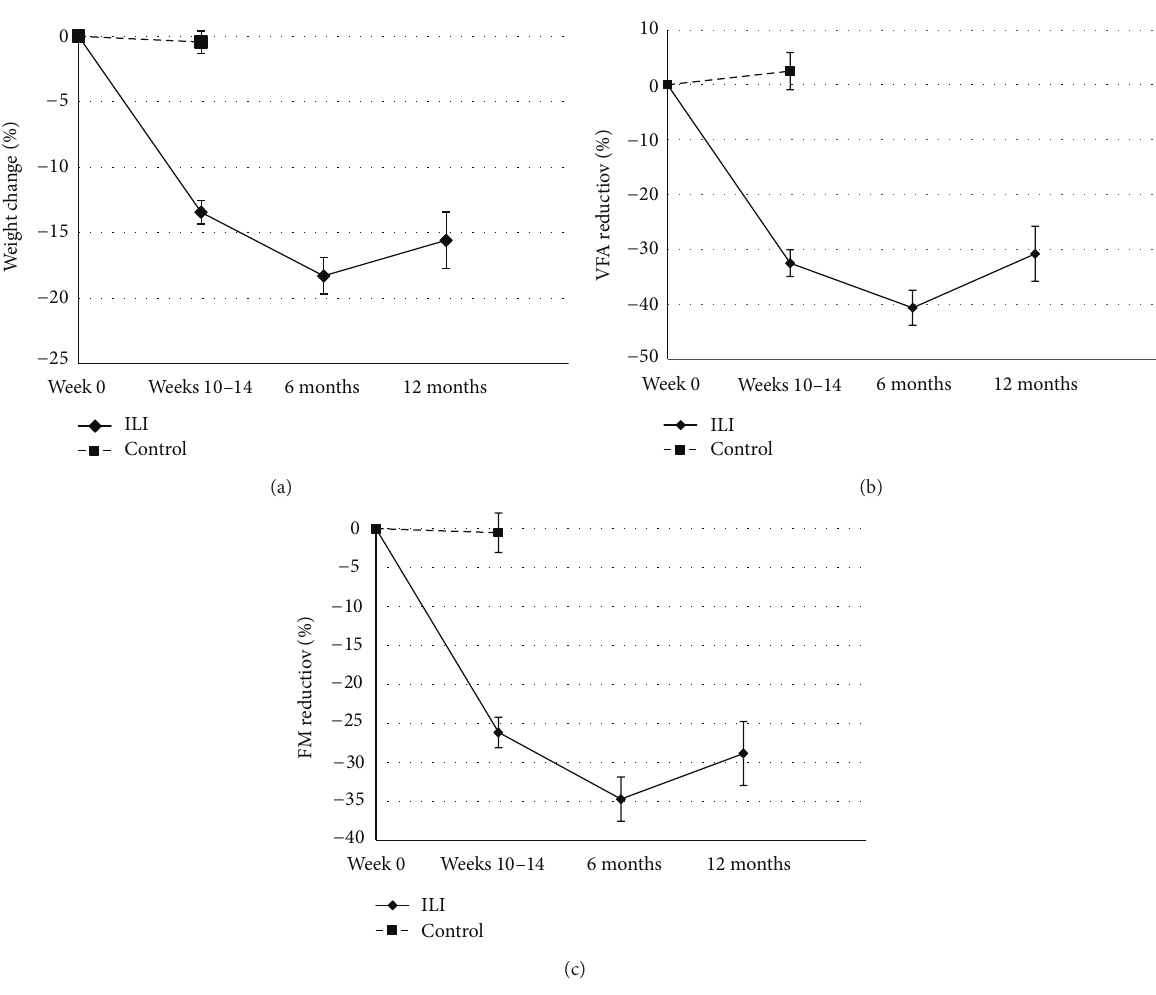
Figure 3: (a) Mean (95% CI) percentage weight loss during followup. (b) Mean (95% CI) percentage reduction in VFA during followup. (c) Mean (95% CI) percentage reduction in FM during followup. Table 2: Between-group differences in changes in body composition from week 0 to weeks 10–14. Data are mean values (standard deviation or 95%